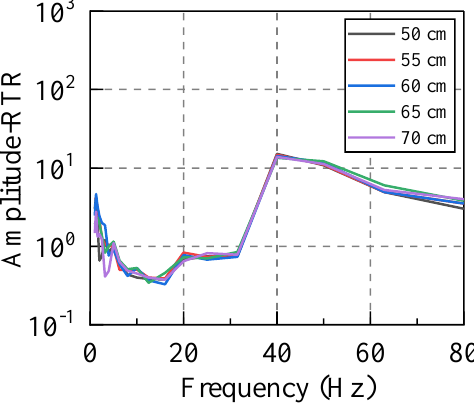
Figure 7. Amplitude − RTR. (Different excitation heights).